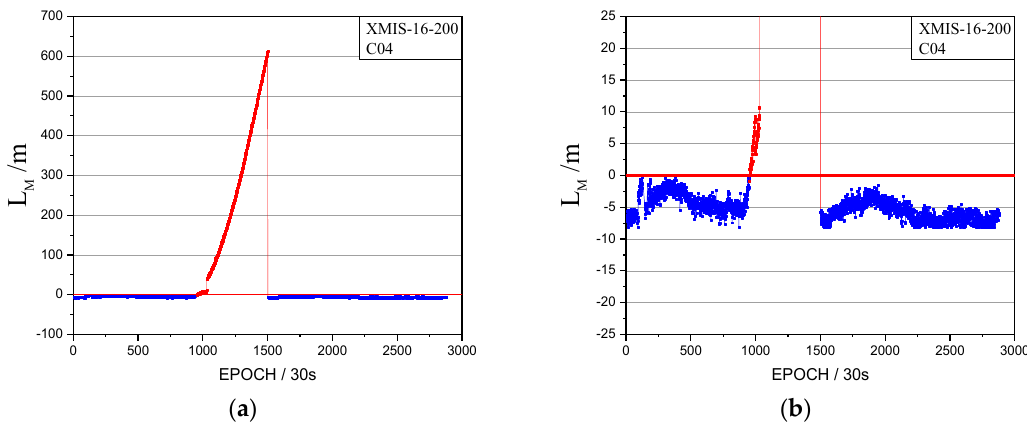
Figure 4. The satellite factor of the orbital maneuver for C04 on 18 July 2016. ( a ): The normal vertical axis scale shows overall information; ( b ): The amplified vertical axis scale shows more detailed information.